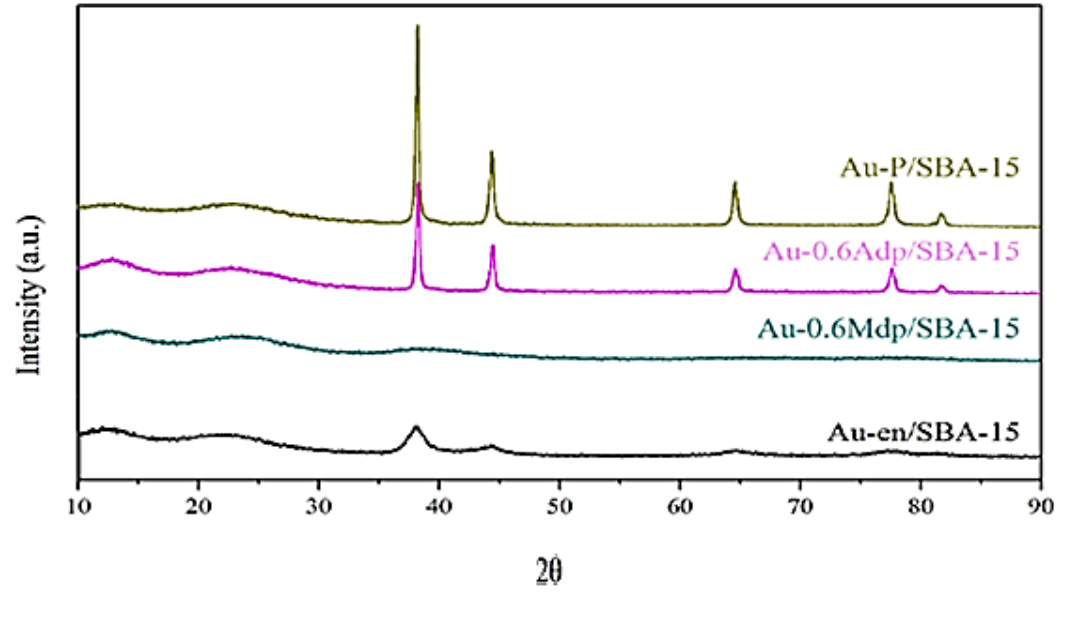
Figure 6. Wide-angle XRD of the fresh samples.